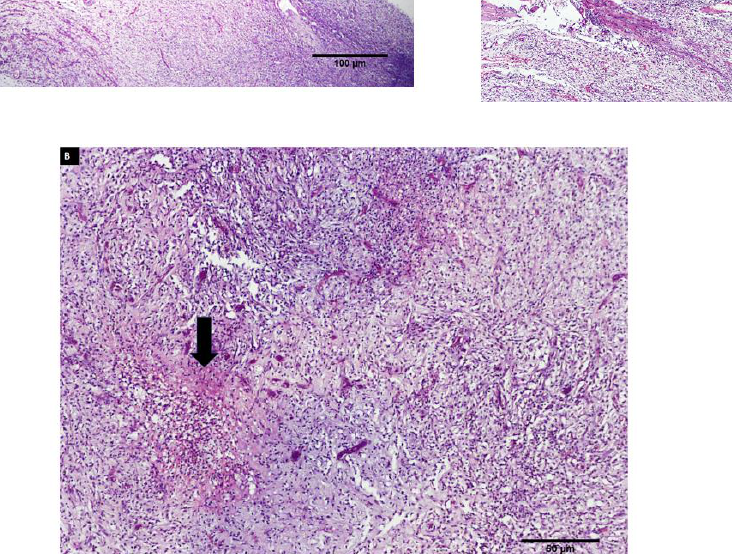
Figure 12. Histological sections stained with H and E of subcutaneous rat tissue surrounding im- planted hydrogels (scaffolds).